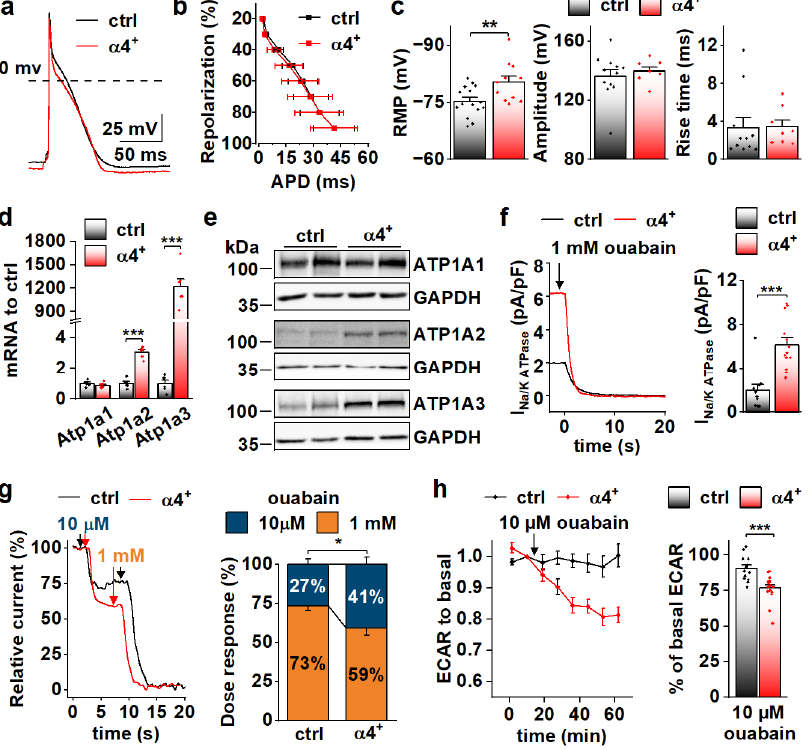
Figure 5. PGC-1 α 4 Overexpression Induces Na-K ATPase Expression and Leads to a Drastic In- crease in Its Current in Neonatal Cardiomyocytes. ( a ) Representative action potentials from cultured neonatal cardiomyocytes. ( b ) Action potential duration (APD) plotted against repolarization phase. ( c ) Resting membrane potential (RMP, left, n [ctrl] = 4/15 (animals/cells), n [ α 4 + ] = 3/11), amplitude (middle, n [ctrl] = 4/12, n [ α 4 + ] = 3/8) and rise time (right, n [ctrl] = 4/11, n [ α 4 + ] = 3/8) of the action potentials. ( d ) mRNA expression of sodium–potassium ATPase isoforms α 1 (Atp1a1), α 2 (Atp1a2) and α 3 (Atp1a3) in ventricles of neonatal control (ctrl) and Pgc-1 α 4 overexpressing ( α 4 + ) ( n = 6). ( e ) Protein expression of sodium–potassium ATPase isoforms in neonatal ventricles. ( f ) Representative Na+/K+ ATPase current traces under application of a saturating concentration of ouabain (left) and statistics of the ouabain sensitive current ( right ) in isolated neonatal cardiomyocytes ( n [ctrl] = 3/11, n [ α 4 + ] = 2/13). ( g ) Representative relative Na + /K + ATPase current traces under consecutive applica- tions of 10 µM and 1 mM ouabain (left) and statistics of relative proportion of the current sensitive to 10 µM ouabain (right) in neonatal cardiomyocytes ( n [ctrl] = 1/7, n [ α 4 + ] = 1/10). ( h ) Changes in glycolytic rate of isolated neonatal cardiomyocytes induced application of 10 µM ouabain ( n [ctrl] = 3/14 (animals/wells), n [ α 4 + ] = 3/17). p -value from hierarchical statistical test (or Student’s t -test in panel d): *, p < 0.05; **, p < 0.01; ***, p < 0.001.